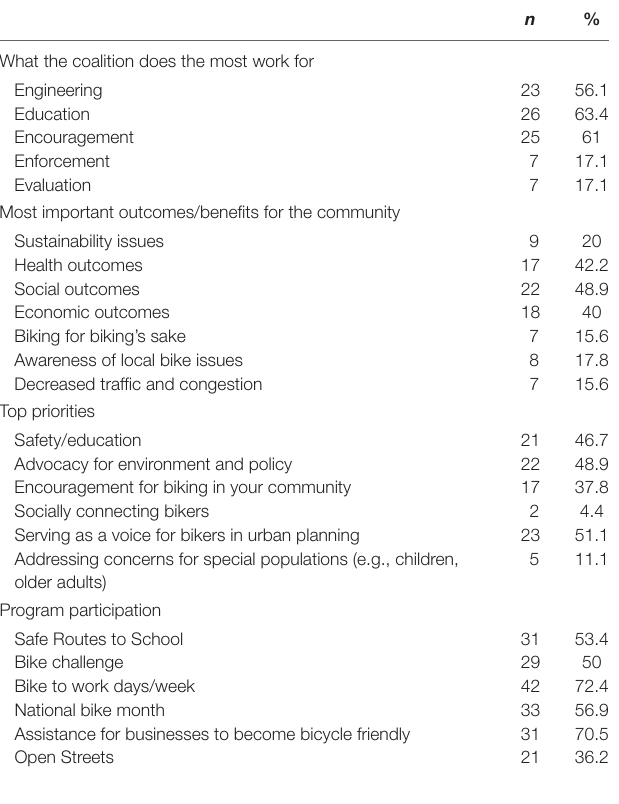
TaBle 2 | Coalition programs and priorities ( n = 56).